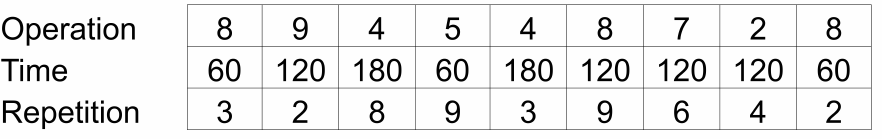
Figure 7. Solution representation of an operating procedure for the drum boiler optimization